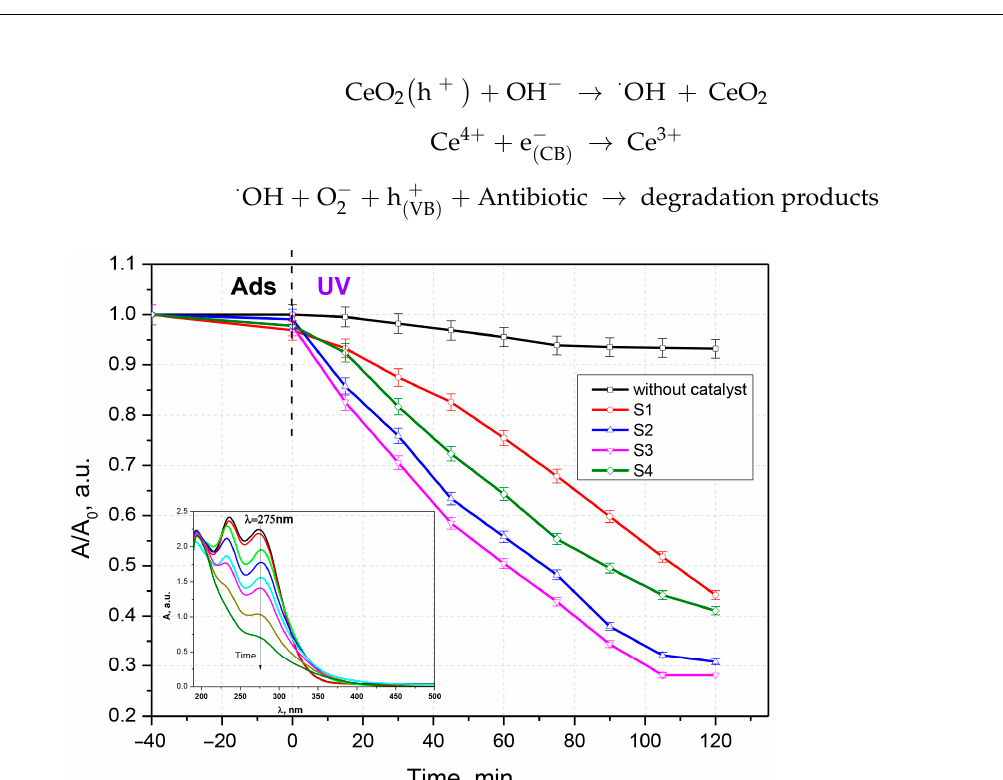
Figure 6. Photocatalytic degradation of ceftriaxone ( a ) and time evolution of the UV-Vis absorption spectrum of ceftriaxone.